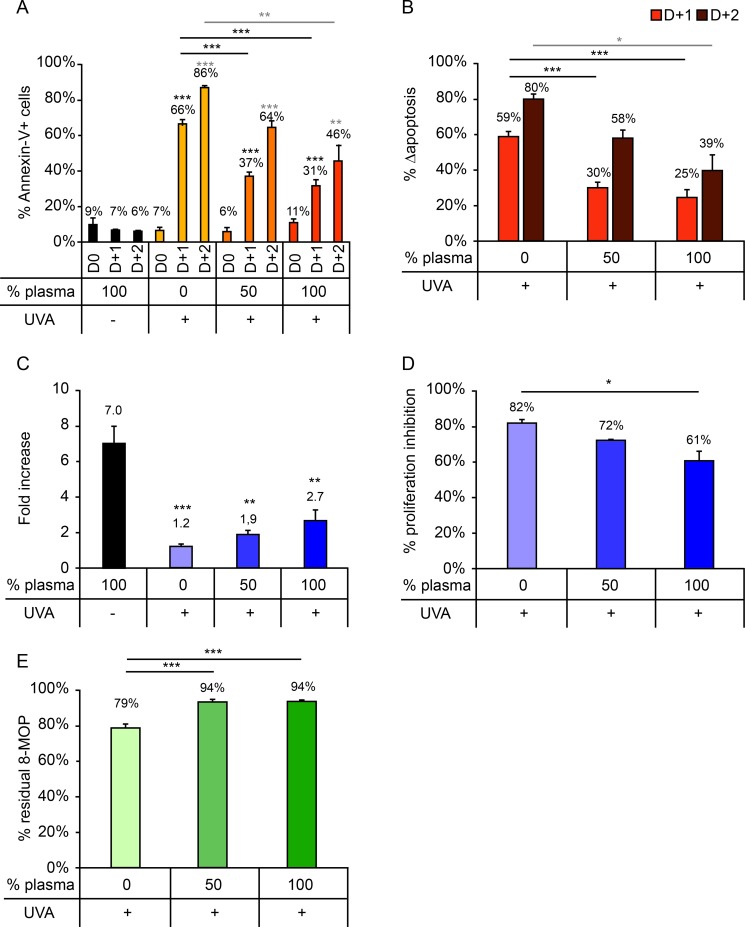
Impact of plasma ratio (0%, 50%, or 100%) on cellular response after UVA irradiation (2 J/cm2).(A) Percentage of Annexin-V+ cells measured daily up to 2 days after irradiation. (B) Δapoptosis determined on days 1 and 2 post-irradiation. (C) Fold increase on day 3 post-irradiation relative to day 0. (D) Proliferation inhibition percentage, calculated as the percentage decrease in proliferation in irradiated versus control samples. (E) Residual 8-MOP remaining in the irradiation container after treatment, expressed as a percentage of the pre-irradiation 8-MOP concentration. Pairwise comparisons of each treatment condition were performed. For clarity, only statistically significant results are shown: *p<0.05; **p<0.01; ***p<0.001. Significant differences with respect to the control (UVA -) are indicated with an asterisk above the relevant bar, while comparisons between irradiated samples are indicated with an asterisk over a line linking the relevant bars. For Annexin-V+ cells (A) and Δapoptosis (B), comparisons performed on days 1 and 2 post-irradiation are indicated in black and gray, respectively.